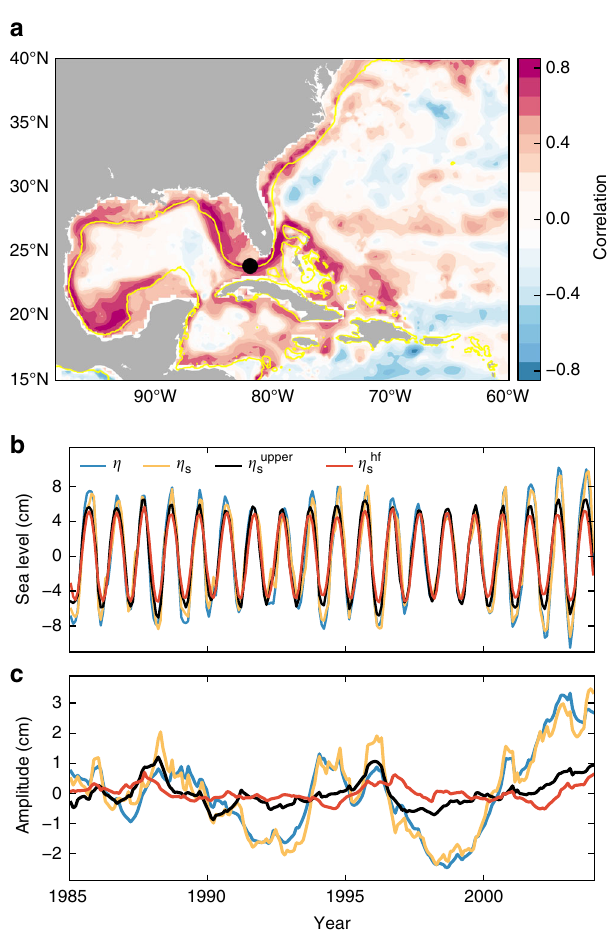
Fig. 5 Correlation map and time series of the steric component from OCCAM. a Point-wise correlation of the steric annual amplitude at each grid point with the SLAC amplitude averaged along the United States Gulf and Southeast coasts. The average has been computed over grid points within the 0 – 500 m depth range following the coast from Pensacola to Charleston. The yellow line represents the 300 m isobath. b The annual cycle of total sea level (blue), total steric height (orange), and the steric contributions from above the seasonal thermocline (black) and due to surface heat fl uxes (red) at the location denoted by the black dot shown in a . c The annual amplitude (time mean removed) of the time series shown in